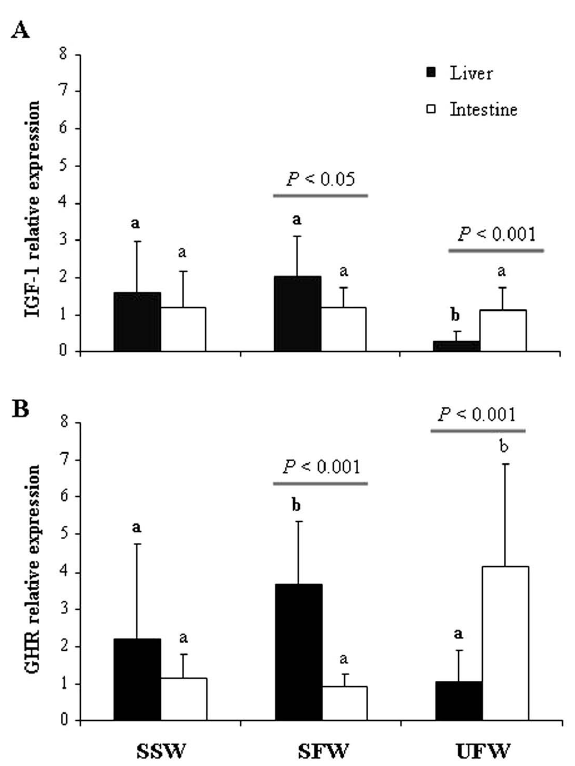
Fig. 2. – Real-time PCR analysis of mRNA expression of (A) IGF-1 and (B) GHR in liver and intestine of European sea bass ( Dicen- trarchus labrax ) for SSW (n=20), SFW (n= 0) and UFW (n=30). Each value represents means + SD. Significant differences in gene expression among tissues within each group of fishes are indicated by a horizontal grey line with the significance level of each test. When tests between tissues were not found significant, this line is not reported (SSW). Different letters indicate significant differences in gene expression among the three groups of fishes. For each gene, different boldface characters report significance among SSW, SFW and UFW for liver, whereas standard characters are for the intestine (P<0.001 in each case, except for GHR in liver: